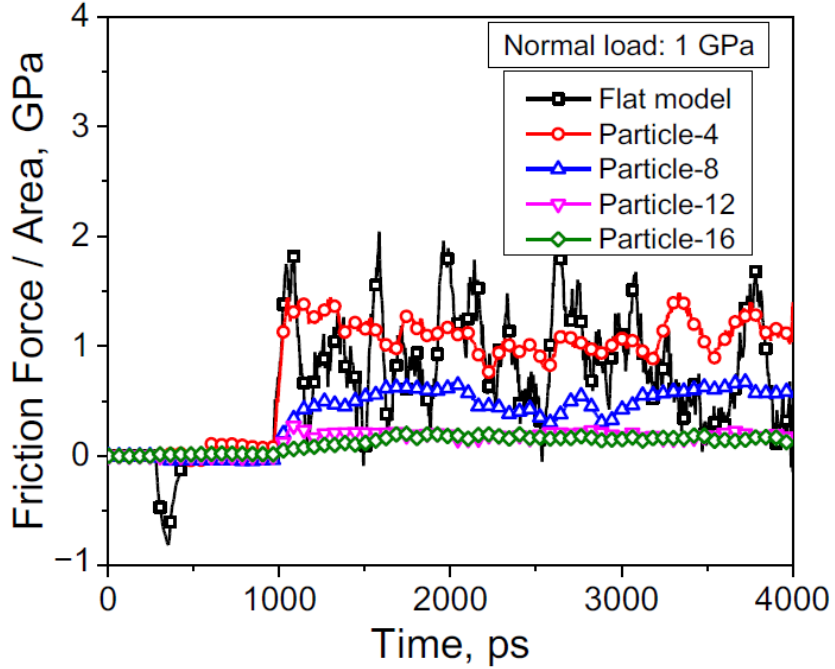
Figure 9. Comparison of the evolution of friction force against the simulation time between the flat model and particle models containing 4, 8, 12 and 16 nanoparticles.